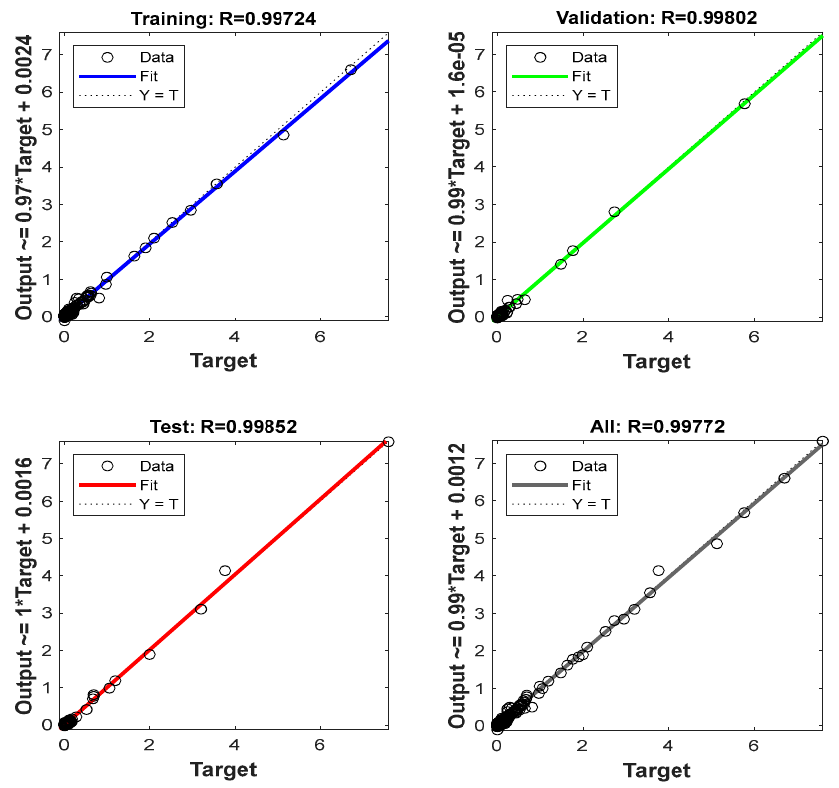
Figure 10. Relationship between experimental values and values predicted by the ANN model. To confirm the performance of this model, analysis of the residue was launched by the frequency method (Figure 11a) and also by the histogram of error method (Figure 11b).